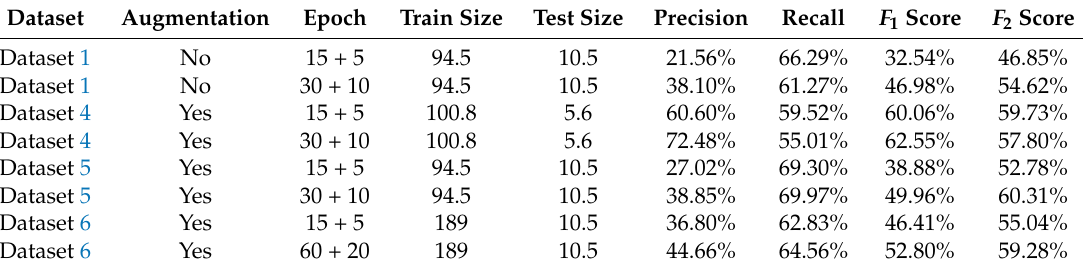
Figure 10. Loss Graphs of Dataset 6. To demonstrate the decrease in loss of both training and test sets depending on epochs, we displayed the loss graphs of Dataset 6 which has the largest number of epochs. Table 6. The results of the effect of training